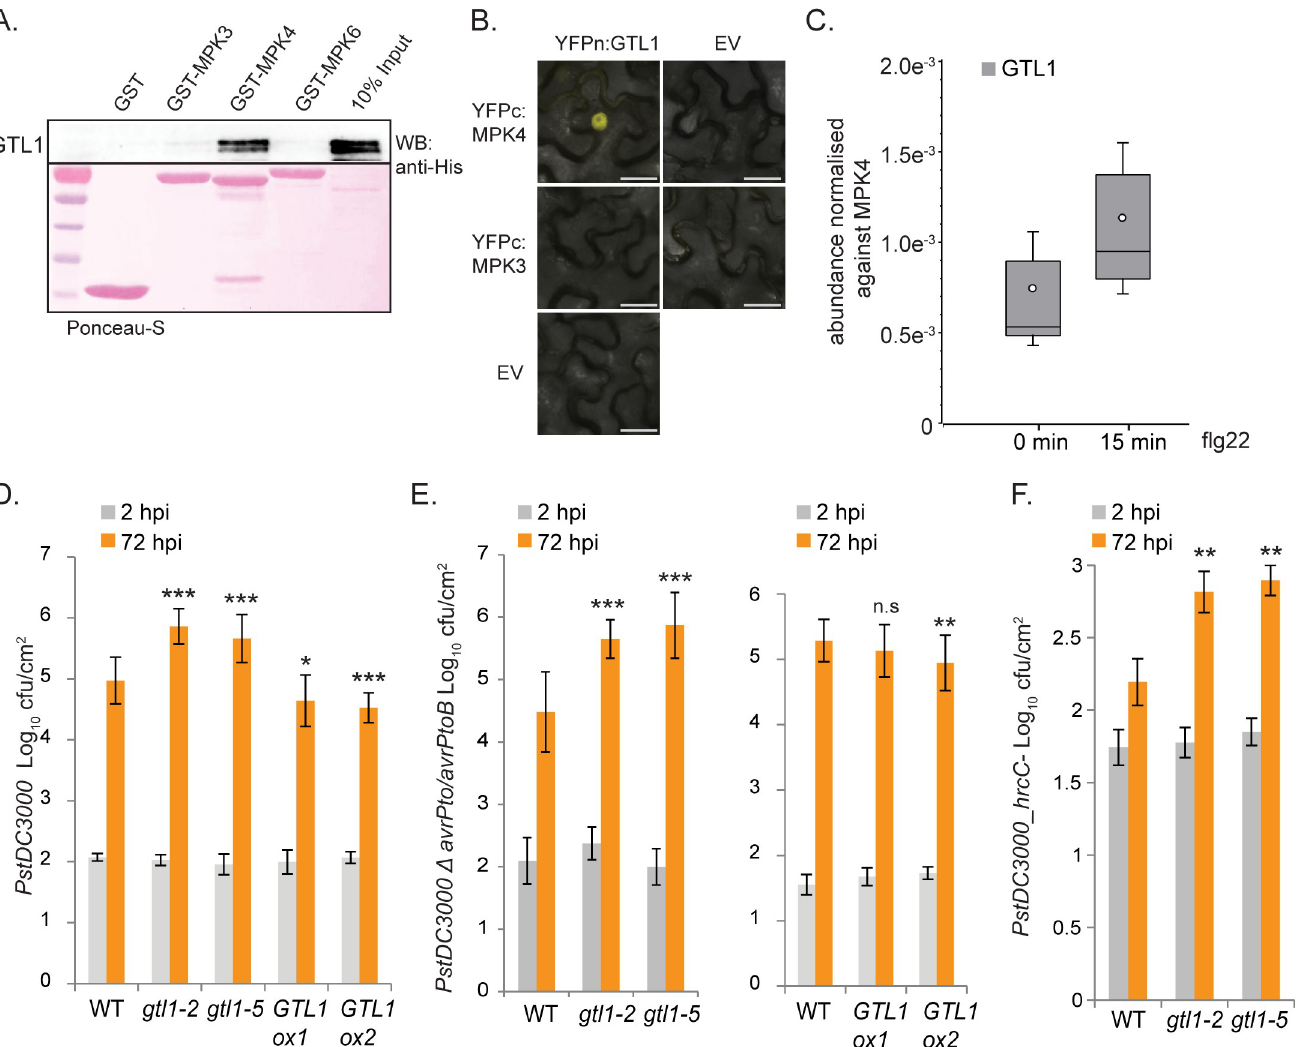
Fig 1. GTL1 associates with MPK4 and allelic gtl1 mutants show higher susceptibility to various Pseudomonas syringae strains. A) In-vitro pull-down assays of MBPHis-tagged GTL1 show interaction with MPK4, unlike to MPK3, MPK6 and single GST. Pull-down assays were performed by incubating bacterial lysates of GST (lane 1), MPK3-GST (lane 2), MPK4-GST (lane 3), and MPK6-GST (lane 4) with GST beads followed by the incubation with bacterial lysate of MBPHis-tagged GTL1 (lane 6, 10% INPUT). The pull-downs and 10% INPUT were probed with an anti-His antibody (WB: anti-His). Proteins were stained with Ponceau-S. B) Nuclear interaction of GTL1 with MPK4. Nicotiana benthamiana epidermal cells were analyzed by Bimolecular Fluorescence Complementation. MPK3 and empty YFPn/ YFPc-vector (EV) serve as a negative control, scale bar = 25 μ m. C) LC-MS/MS analysis of co-immunoprecipitated MPK4-GTL1 complex. A genomic TAP- tagged MPK4 construct was generated, stably introduced in Arabidopsis thaliana , and used for tandem affinity purification of MPK4 protein without treatment and 15 min after flg22 application. GTL1 was reproducibly identified via the GTL1-specific peptide EETLALLR whose relative abundance was normalized to MPK4 protein abundance. Box plots are depicted for GTL1 protein abundance associated with MPK4, boxes showing the interquartile range (IQR) 25 st to 75 th percentiles, inner ellipse representing the median, whiskers show the SEM. D-F) The allelic GTL1 mutants gtl1-2 and gtl1-5 , as well as two GTL1 -overexpressing lines ( GTL1ox1 , GTL1ox ) were challenged by the use of PstDC3000 , PstDC3000 Δ avrPto/avrPtoB and PstDC3000 hrcC- ( GTL1ox , see under S2C Fig). Plants, of three biological replicates (n = 30), were spray-inoculated with a bacterial suspension at OD 600 0.2, the density of colony-forming units (cfu) was analyzed 2 and 72 hours post inoculation (hpi). Error bars, mean ± SEM, statistical significance was analyzed by Student’s test, asterisks indicate significant differences compared to treated WT, � p � 0.05, �� p � 0.01, ��� p �